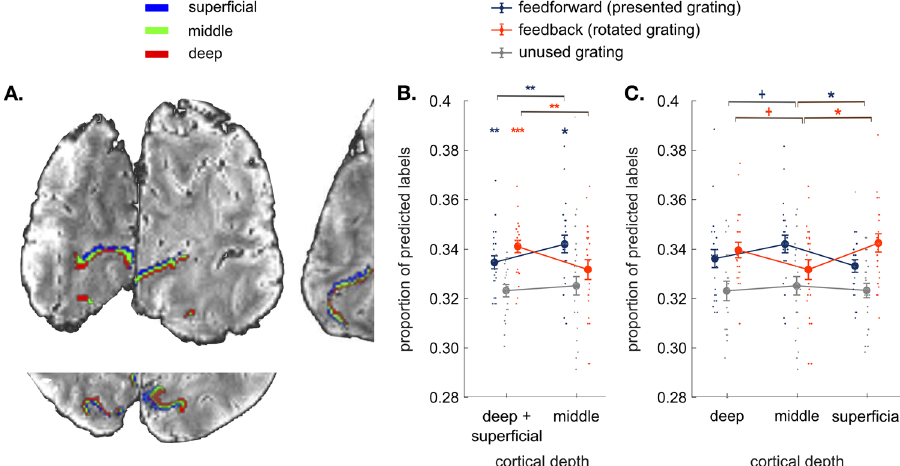
Fig. 2 Results. A Coronal, axial, and sagittal slices of the average EPI image of a representative participant, overlaid with cortical depth bins approximating cortical layers (super fi cial, middle, and deep) from an equi-volume model (see Methods). The cortex is mapped within the region of V1 with voxel eccentricity values 0 – 3°. B Classi fi er decisions in V1 over the time interval measured at 8 and 10 seconds after the rotation onset for the presented, mentally rotated and unused gratings in the outer cortical bins (average of the super fi cial and deep bin) and the middle cortical bin ( N = 23 participants; see Supplementary Fig. 3 for detailed analysis within an extended time interval and Supplementary Fig. 4 for analyses across all time points). Perceptual contents were more strongly represented at the middle cortical depth, whereas mentally rotated contents were dominant at the outer cortical bin. C Comparing classi fi er decisions between all three cortical bins (super fi cial vs. middle vs. deep) reveals that the difference between perceived and rotated contents is most pronounced between the middle and super fi cial depths. All error bars denote standard error of mean over subjects. + p < 0.09, * p < 0.05, ** p < 0.01, *** p <